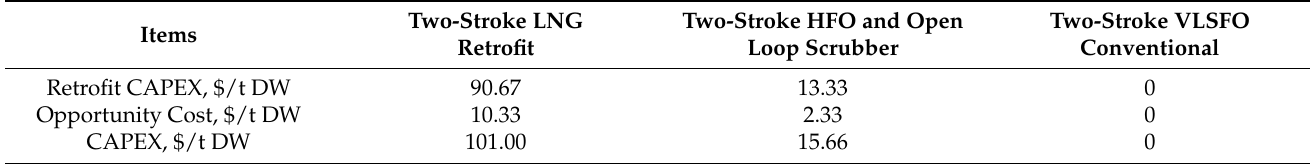
Table 1. CAPEX alternatives in retrofit LNG, retrofit open loop scrubber and reference VLSFO. Two-Stroke LNG Two-Stroke HFO and Open Items Retrofit Loop Scrubber